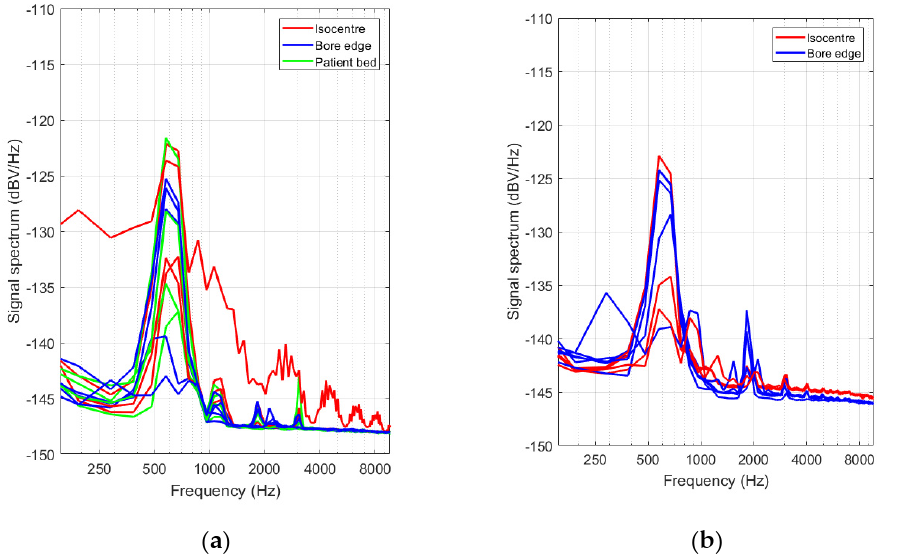
Figure 17. ( a ) Fiber transmission signal spectra acquired with the actuator tip partially interrupting the beam in the gap between the input and output fiber in one of the two channels. Different datasets are grouped according to their respective test location, indicated by different colors: scanner isocenter (red solid line), end of the bore on the patient bed (green) and right next to the scanner bore opening (blue). ( b ) Amplitude spectra acquired for signals acquired on the second experimental campaign. Color coding is identical as in panel ( a ).